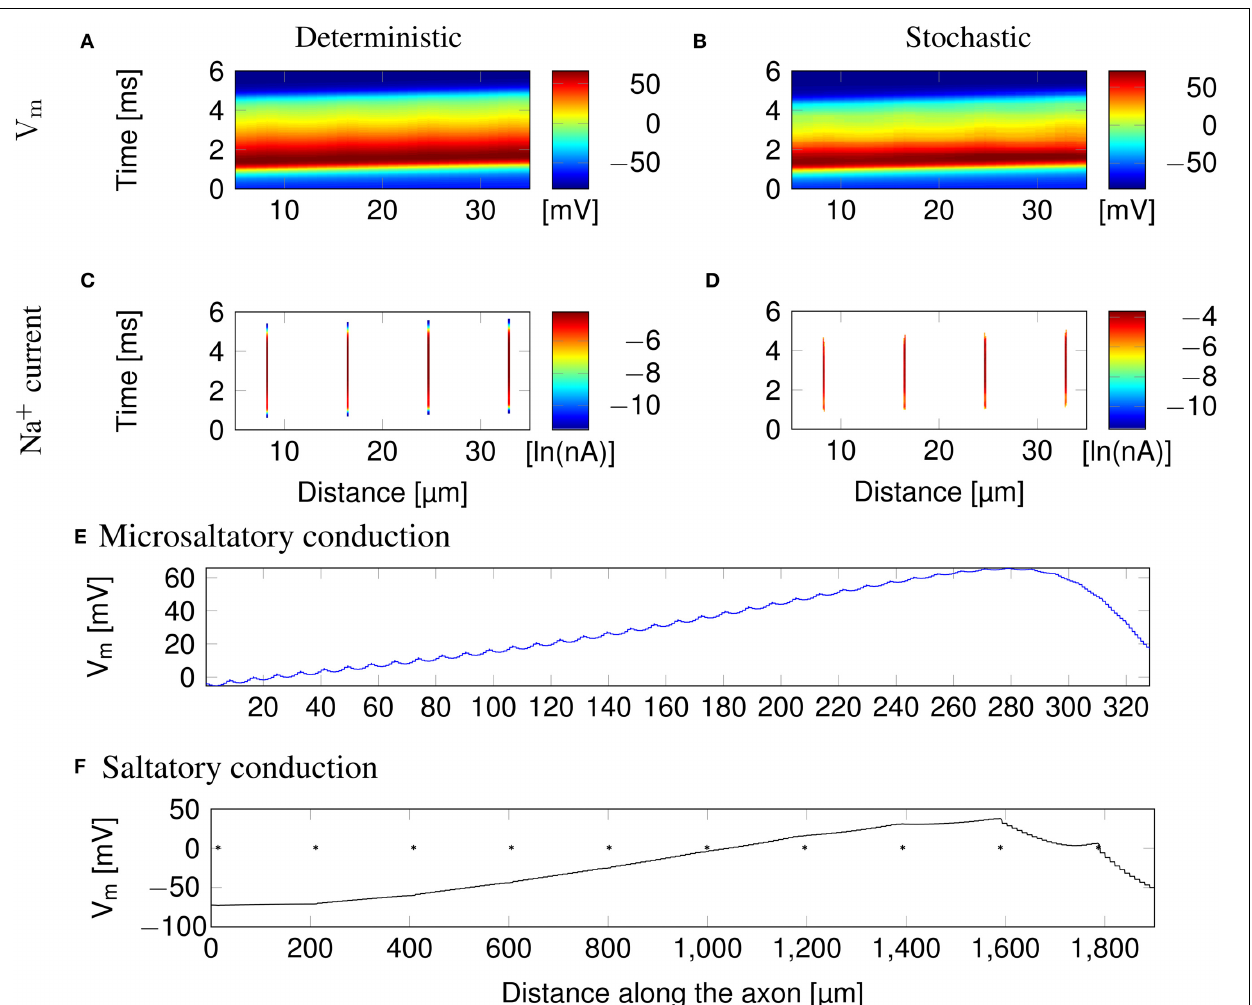
FIGURE 3 | Microsaltatory conduction in a 0.1 µ m diameter C-fiber axon with clustered Na + channels ( l = 0 . 2 µ m, L = 8 µ m). (A) The membrane potential and (C) Na + current in a deterministic simulation. (B) The membrane potential and (D) Na + current in a single trial of stochastic simulations. In (C,D) the lines of Na + current are very fine due to the short length of lipid rafts.